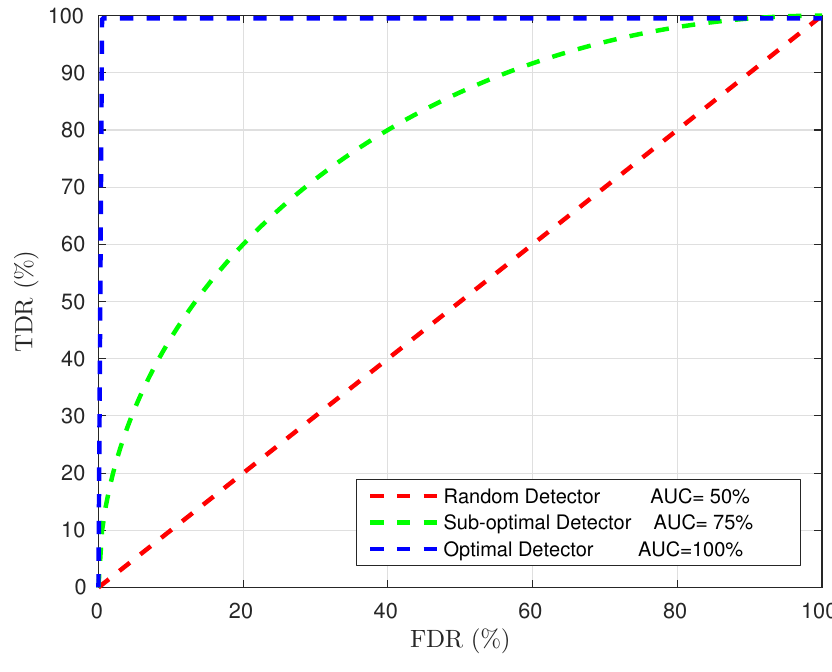
Figure 7. Examples of the ROC and AUC relations.